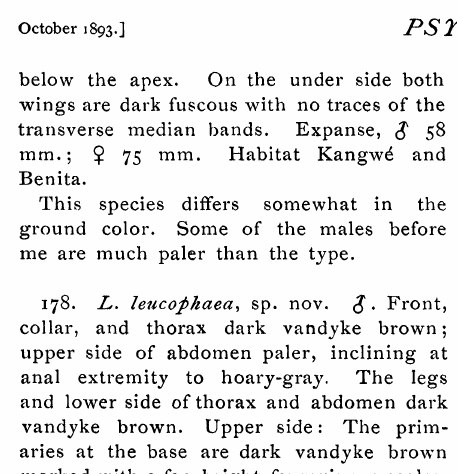
reddish-brown. Upper side of abdomen pale pinkish-brown; legs and under side of the body pale pinkish brown, the anterior margins of the legs being marked with dark brown. Upper side: The primaries are pale pinkish- brown of the same color as the upper side of the abdomen with a dark brown band of the same color as the upper side of the thorax extending obliquely fl’om the costa at the base to the outer angle. The apical third of the wing below the costa is clouded with., the same dark brown color. There is a small silvery spot at the end of the cell, and3 very narrow and obscure angulated trans- verse basal, median, limbal, and submar- ginal lines. The secondaries are pale pinkish brown of the same shade as the upper side of the abdomen and have an obscure incomplete transverse median line on the costa. On the under side, both wings are pale pinkish-brown, the dark lines of the